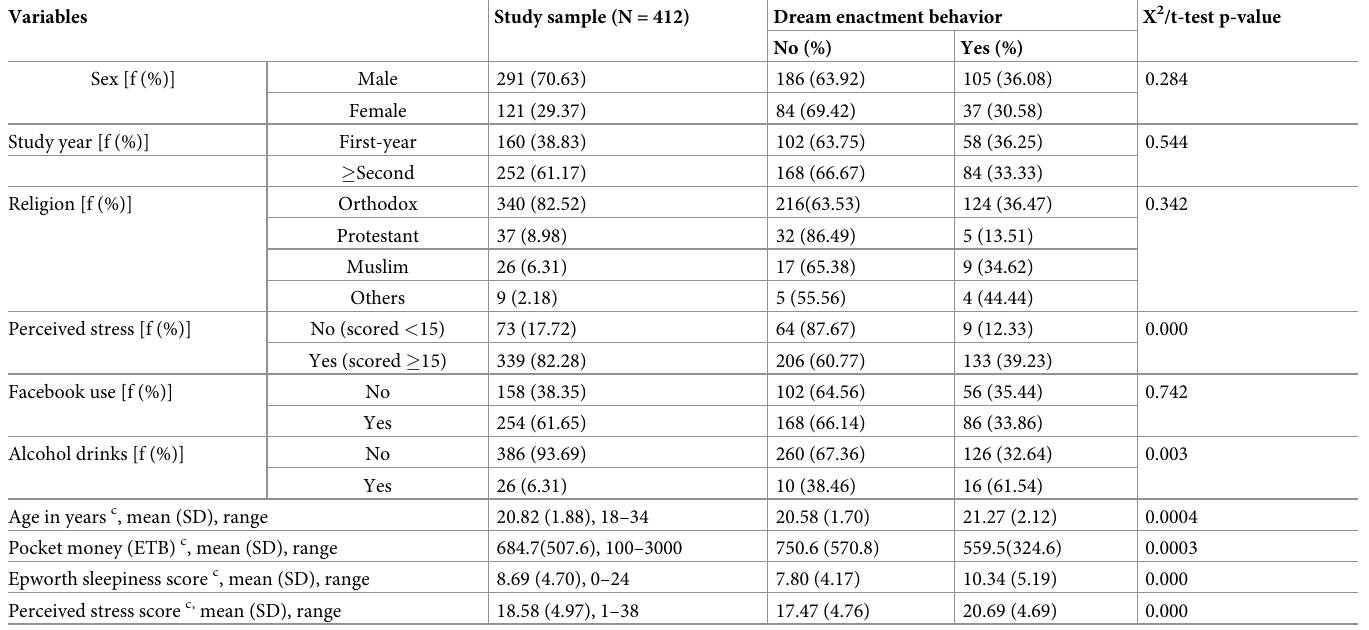
Table 1. Descriptive characteristics by dream enactment behavior of Medical students of University of Gondar, Northwest Ethiopia, 2021. Variables